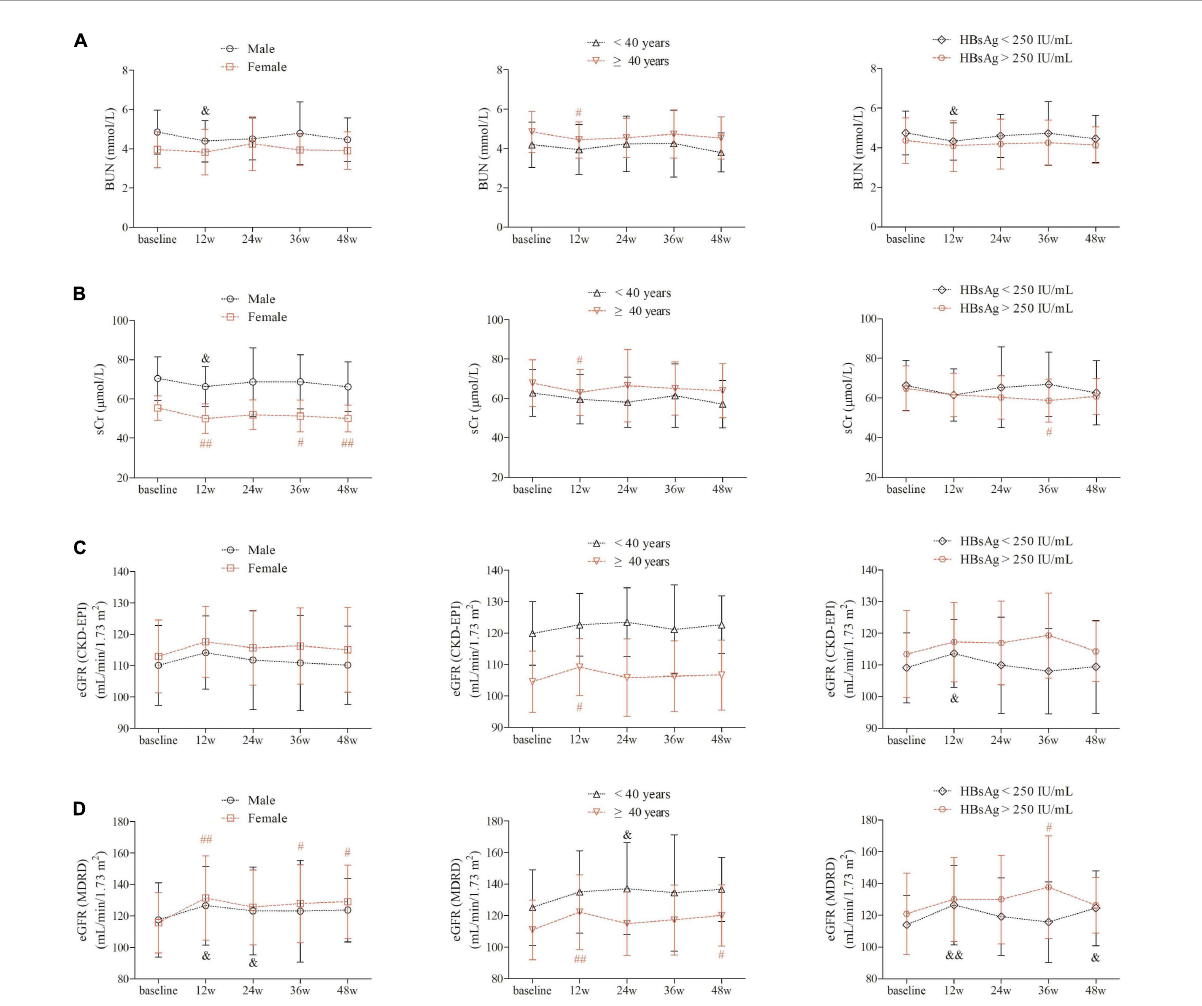
FIGURE2 Evolution of renal function by PEG-IFN α 2b add-on therapy over 48 weeks under different factors. (A) Change of BUN between different gender, between different age ( < 40 years and ≥ 40 years), and between different baseline HBsAg level ( < 250 and > 250 IU/mL). (B) Changes of sCr between different gender, between different age ( < 40 and ≥ 40 years), and between different baseline HBsAg level ( < 250 and > 250 IU/mL). (C) Changes of eGFR as calculated by CKD-EPI formula between different gender, between different age ( < 40 and ≥ 40 years), and between different baseline HBsAg level ( < 250 and > 250 IU/mL). (D) Changes of eGFR as calculated by MDRD formula between different gender, between different age ( < 40 and ≥ 40 years), and between different baseline HBsAg level ( < 250 and > 250 IU/mL). Statistical analysis was performed using one-way ANOVA followed by Tukey test. & and # indicates P < 0.05 compared with baseline. && and ## indicates P < 0.01 compared with